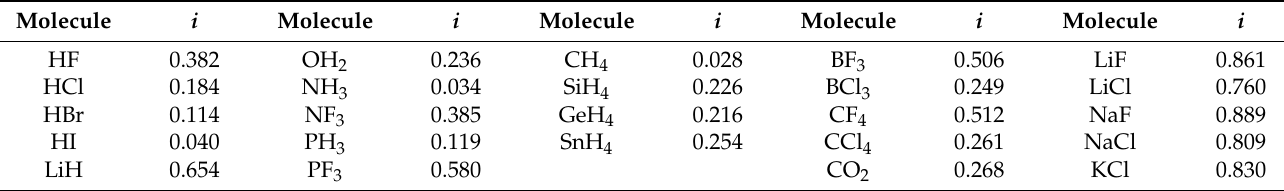
Table 8. IRS-bond ionicity (e* / v ) in